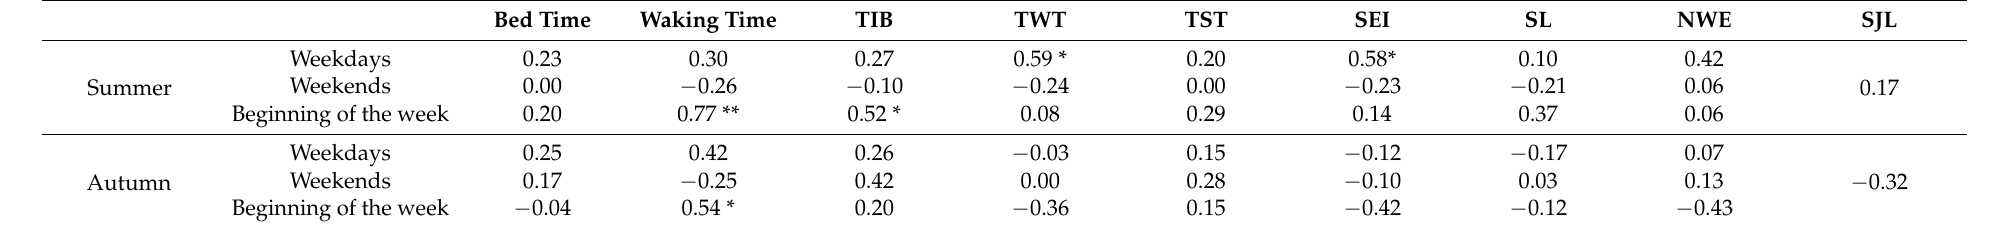
Table 2. Correlation coefficients in sleep parameters between the mothers and high school